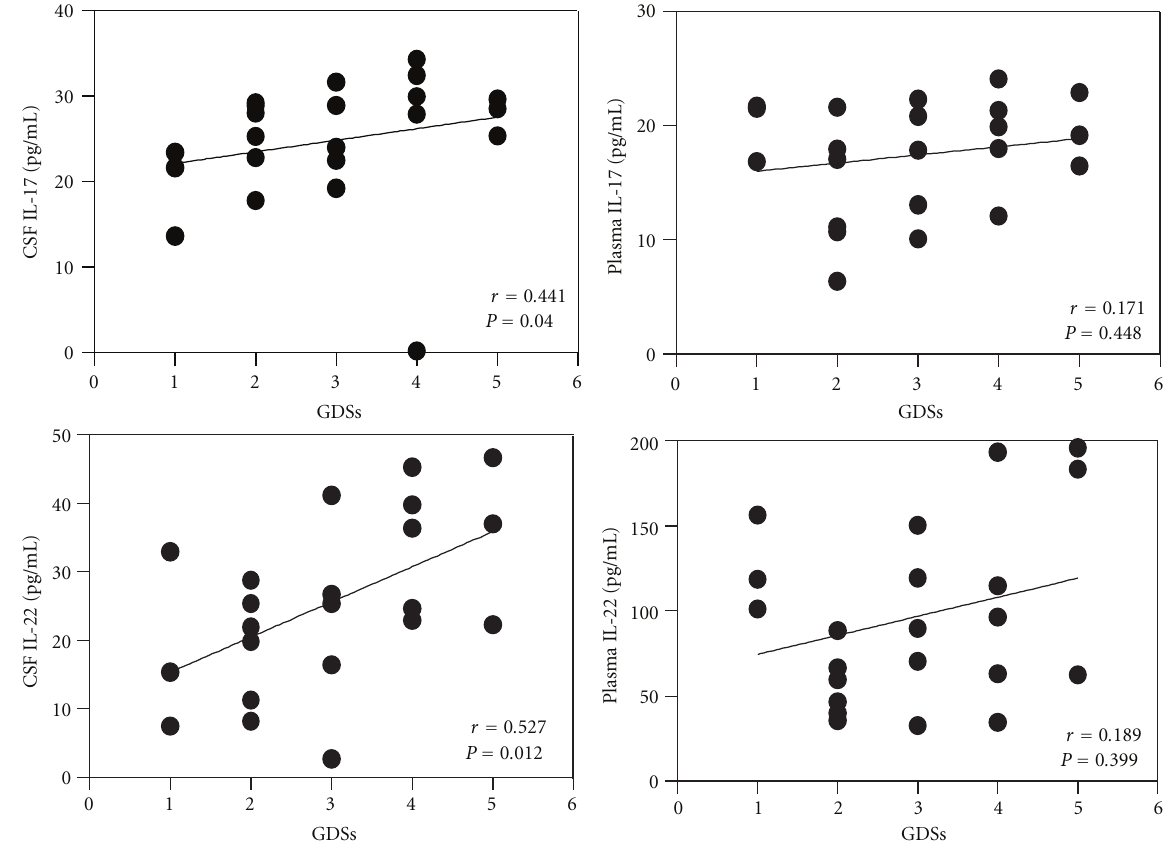
Figure 2: The correlations of CSF and plasma levels of IL-17 and IL-22 with GBS disability scale scores (GDSs). The Spearman correlation coe ffi cient was used to analyze between two sets. Each circle = single individual; lines = linear